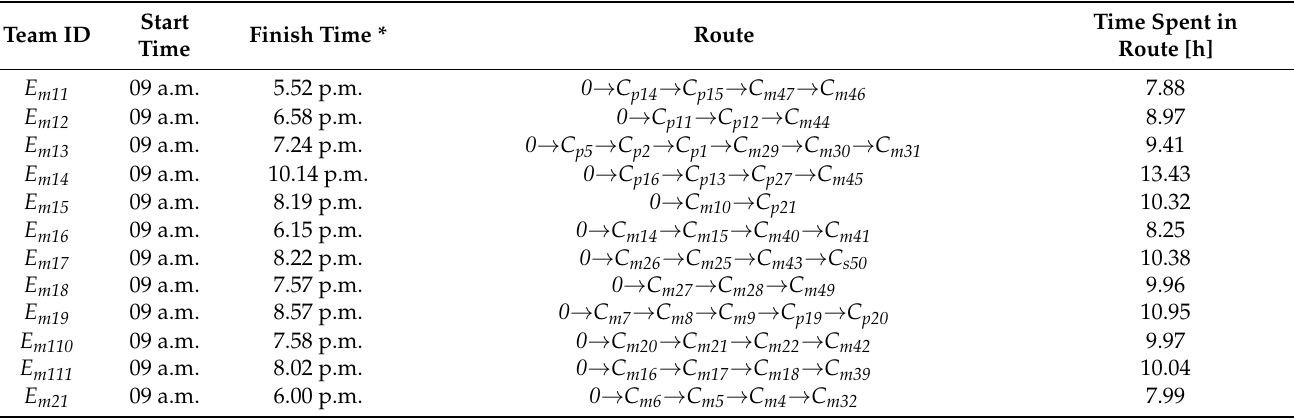
Table A1. Routes Obtained for M-Type Teams through the Proposed